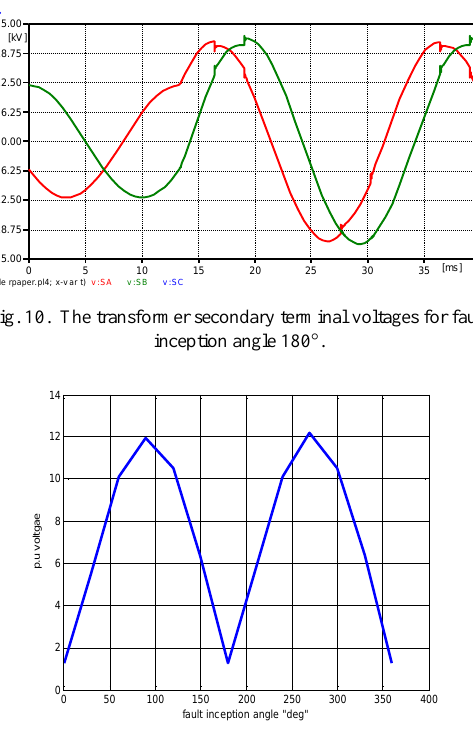
Fig. 11. Instantaneous voltage for phase-c secondary to the base of fault inception angle.